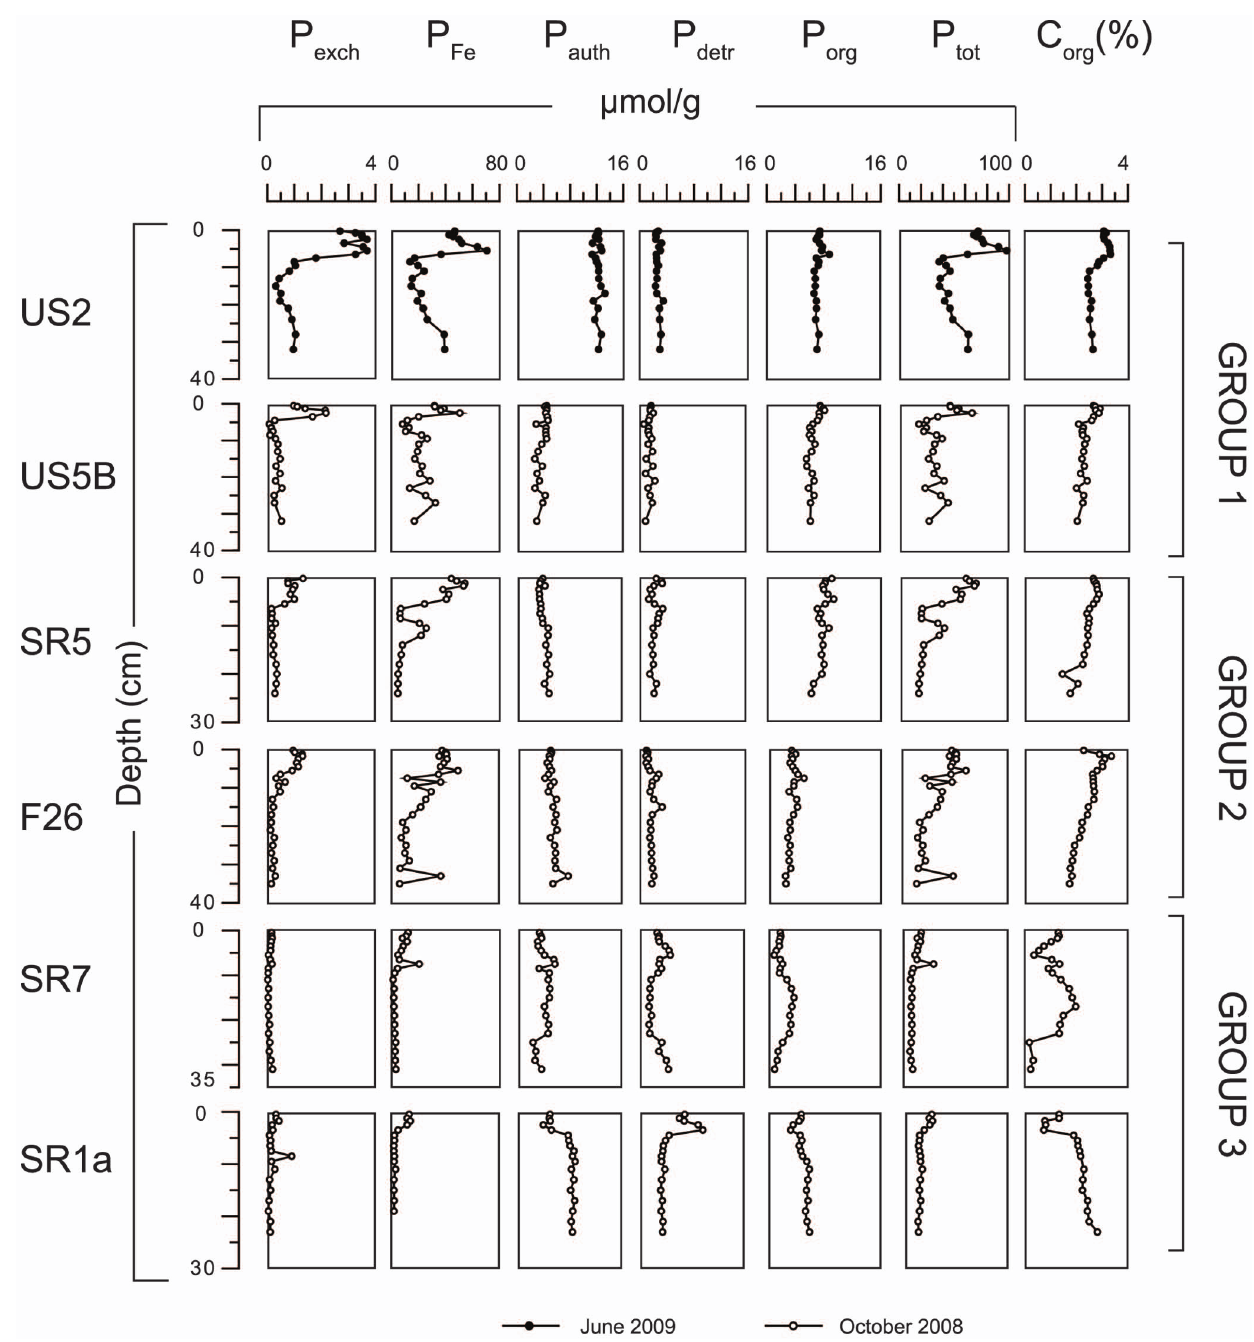
Figure 5. Sediment phosphorus speciation (in m mol/g) and organic carbon contents (C org in wt%) for all sites.